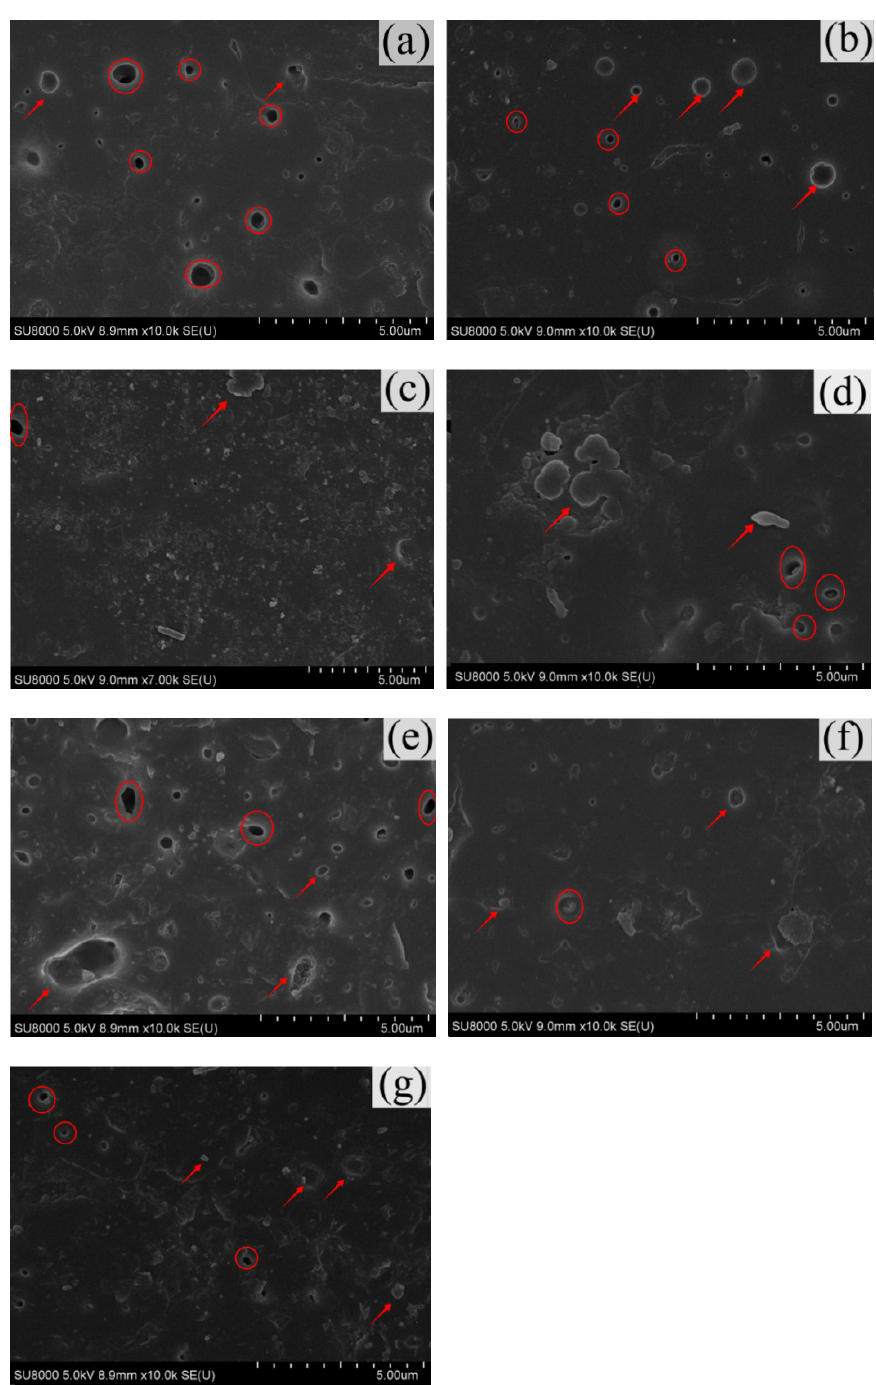
Figure 7. SEM image of RL/FR film surface: ( a ) RL, ( b ) RL/5%IFR, ( c ) RL/10%IFR, ( d ) RL/15%IFR, ( e ) RL/20%IFR, ( f ) RL/25%IFR, and ( g ) RL/30%IFR.